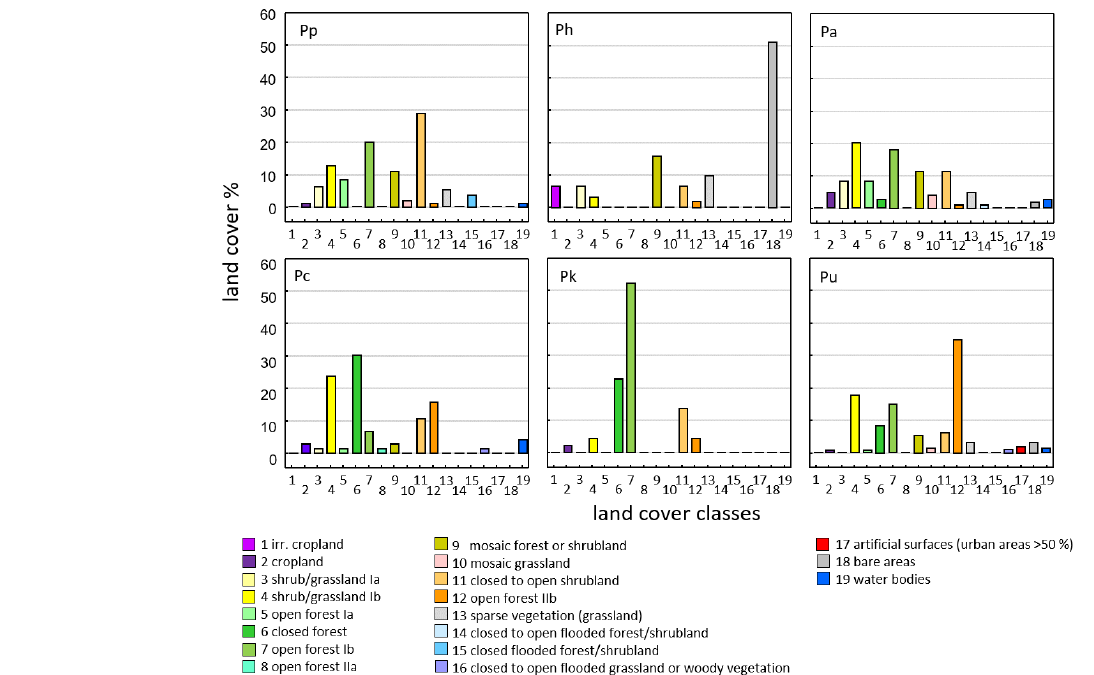
Figure 6. Proportion of land cover classes at sites of the six baboon species (GlobCover, Arino et al., 2012). Baboon species (number of occurrence sites): Pp – P. papio (177), Ph – P. hamadryas (64), uni-level social organization Pa – P. anubis (120), Pc – P. cynocephalus (96), Pk – P. kindae (32), Pu – P. ursinus